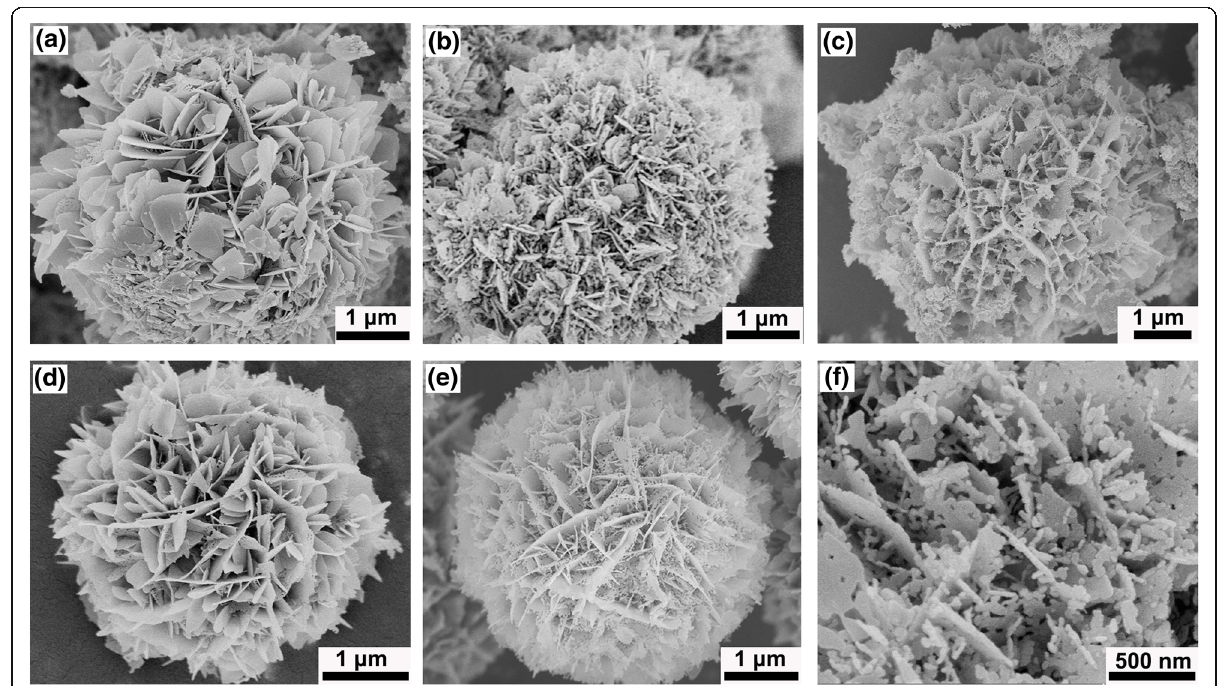
Fig. 4 The SEM images of the SnO 2 nanoflowers with different morphologies. a S 0 , b S TritonX-100 , c S HMT , d S PEI , and e , f S